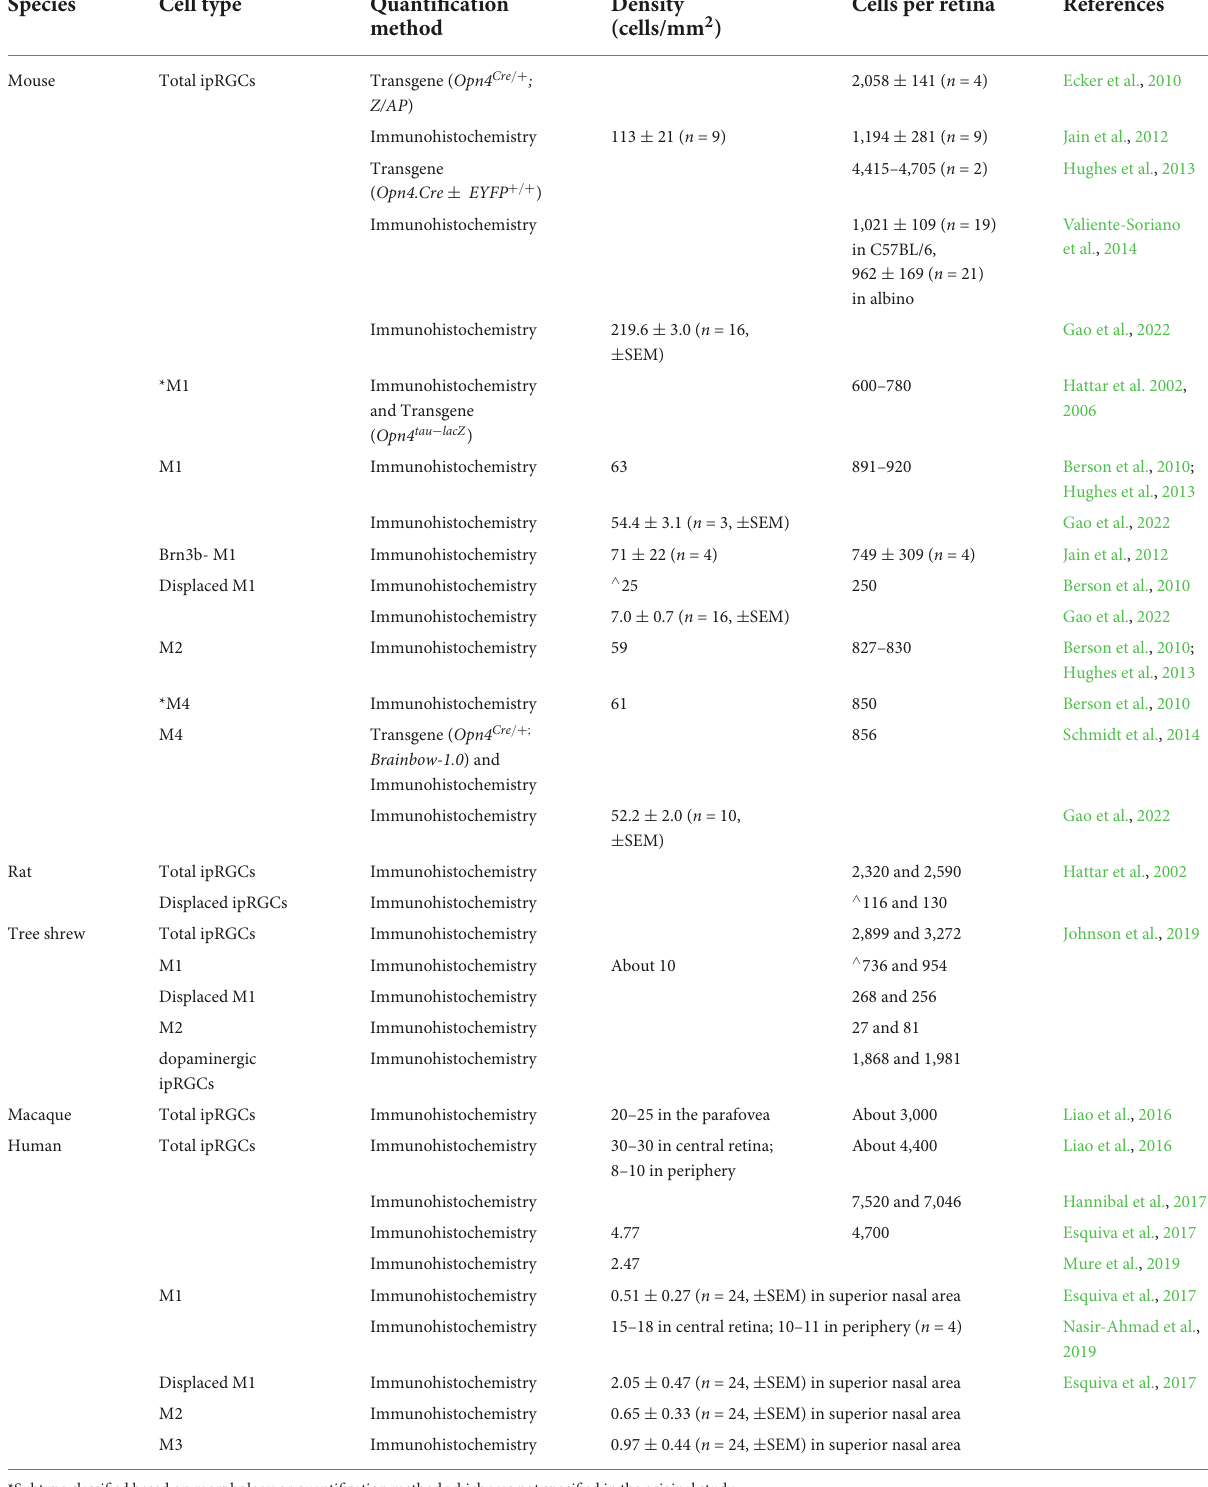
TABLE 1 Comparisons of intrinsically photosensitive retinal ganglion cell (ipRGC) densities in various models.